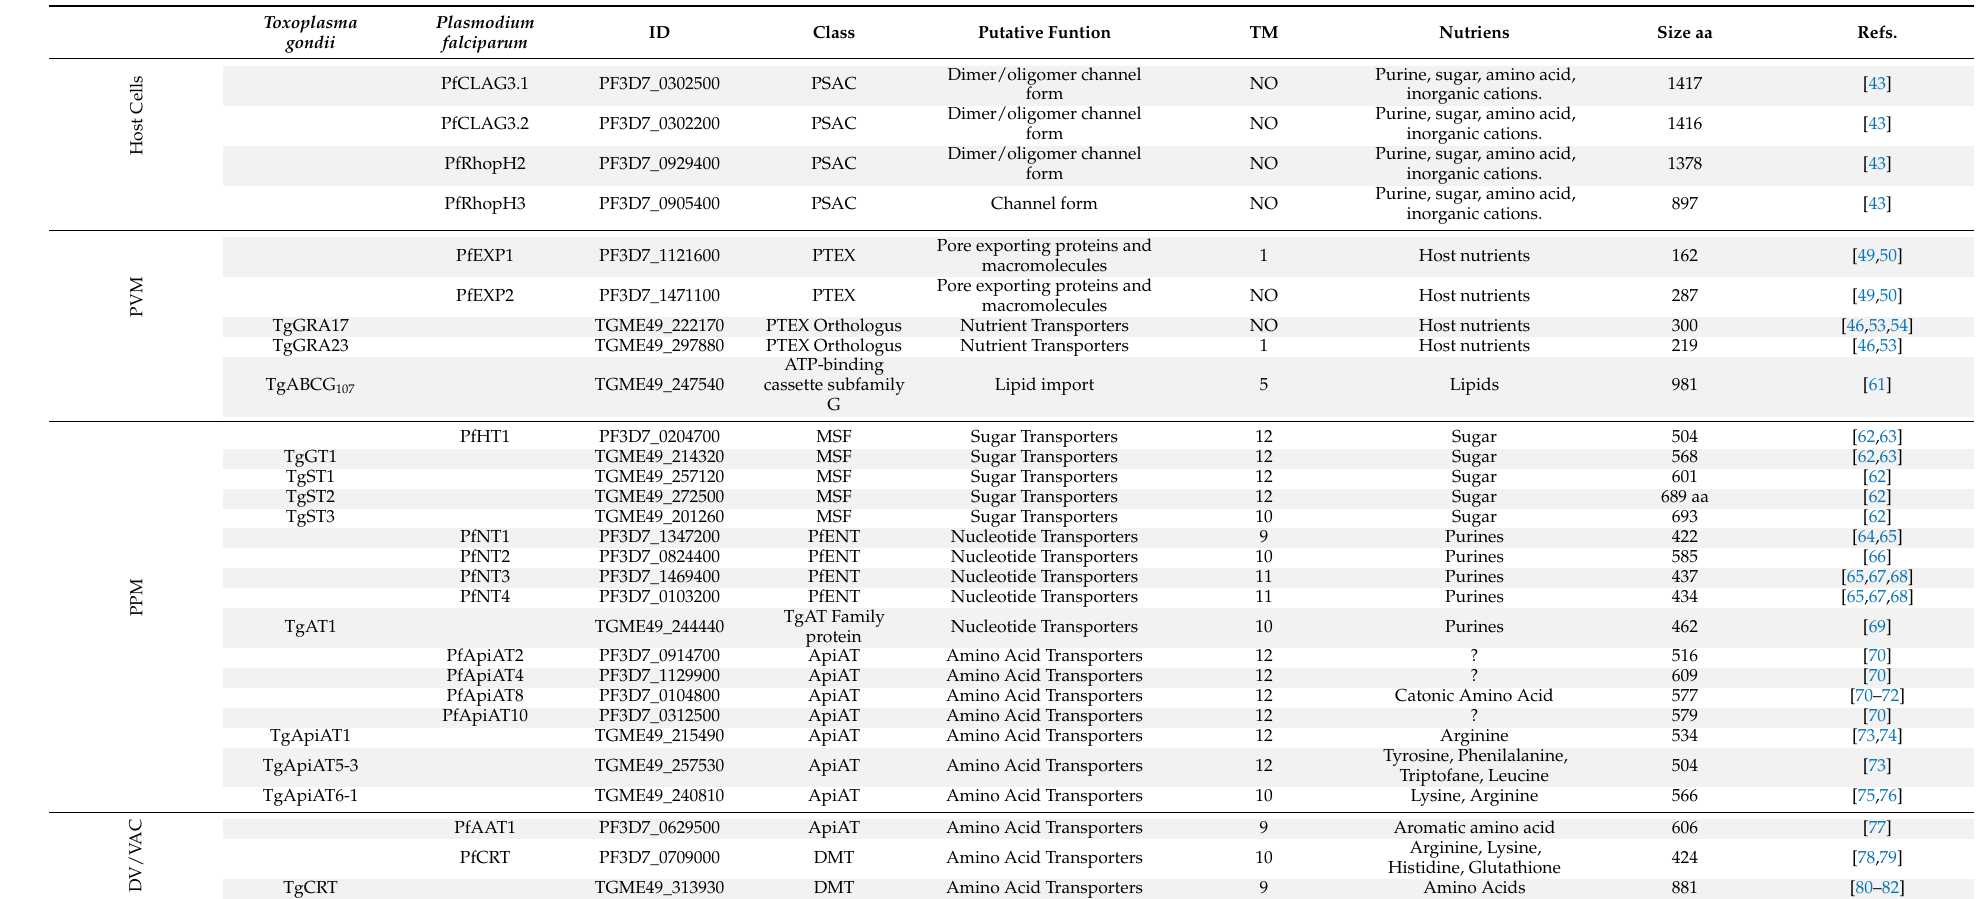
Table 2. Transporters in Plasmodium falciparum and Toxoplasma gondii